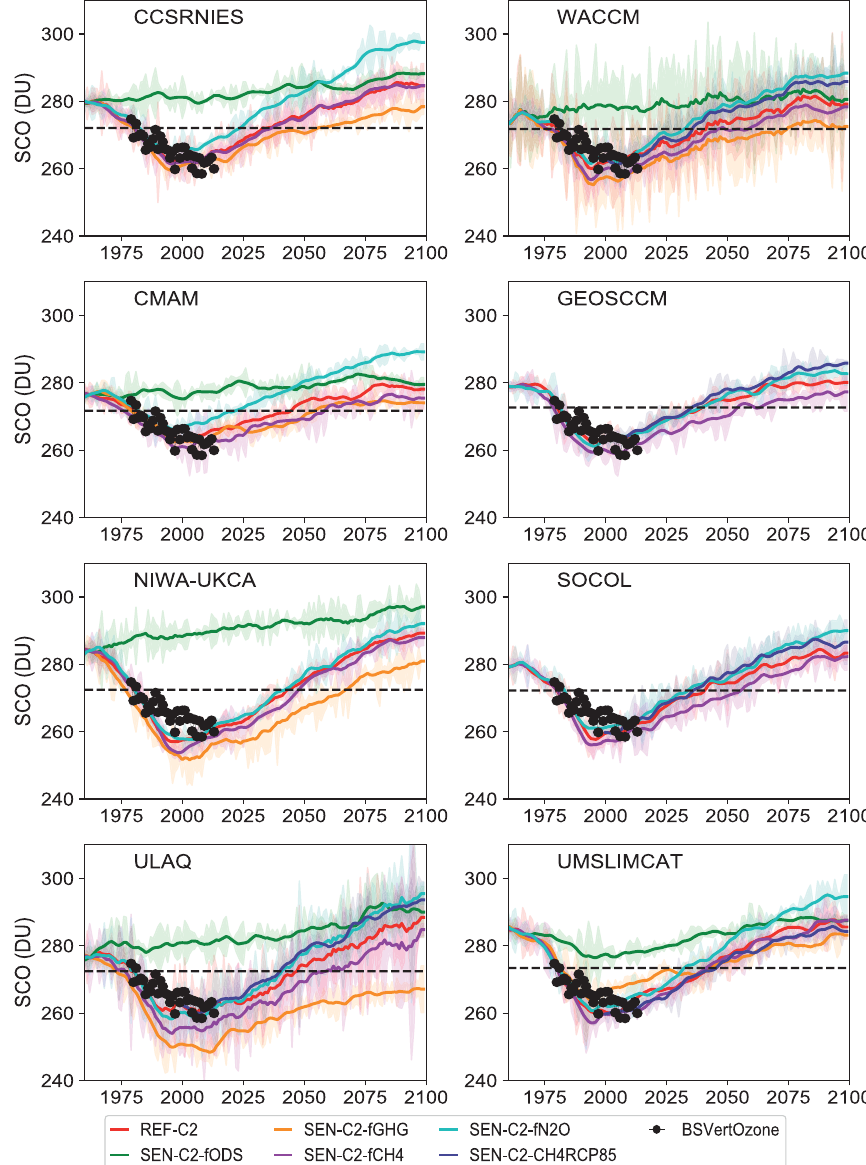
Figure 14. As Fig. 13 but for SH mid-latitude annual